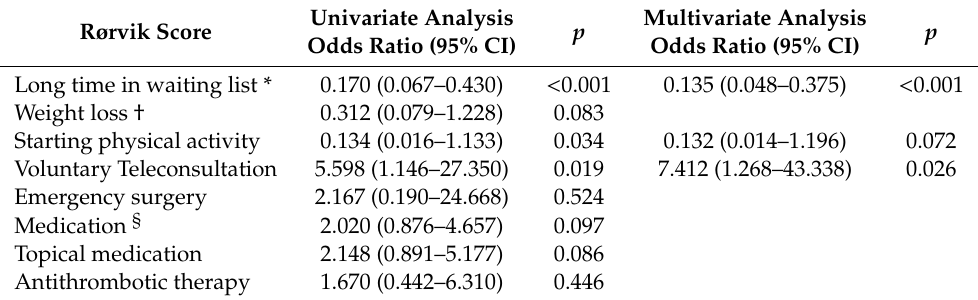
Table 3. Univariate and Multivariate analysis of the factors related to Rørvik score